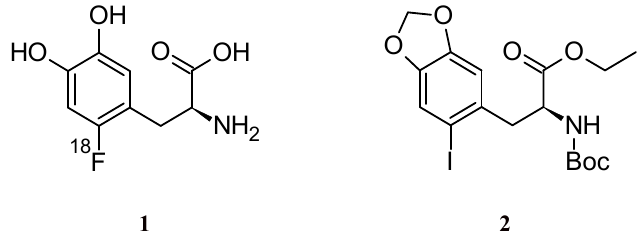
Figure 1. 6-[ 18 F]Fluoro levodopa ( 1 ) and ( S )-ethyl 2-( tert -butoxycarbonylamino)-3-(2-iodo-4,5- methylenedioxyphenyl)propanoate ( 2 ).